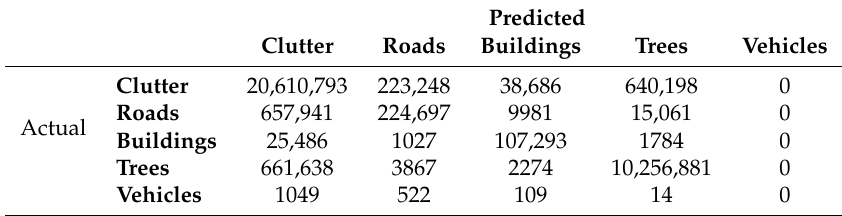
Table A12. Confusion matrix for the decision tree model that is trained on hand-crafted coordinates features and color features.